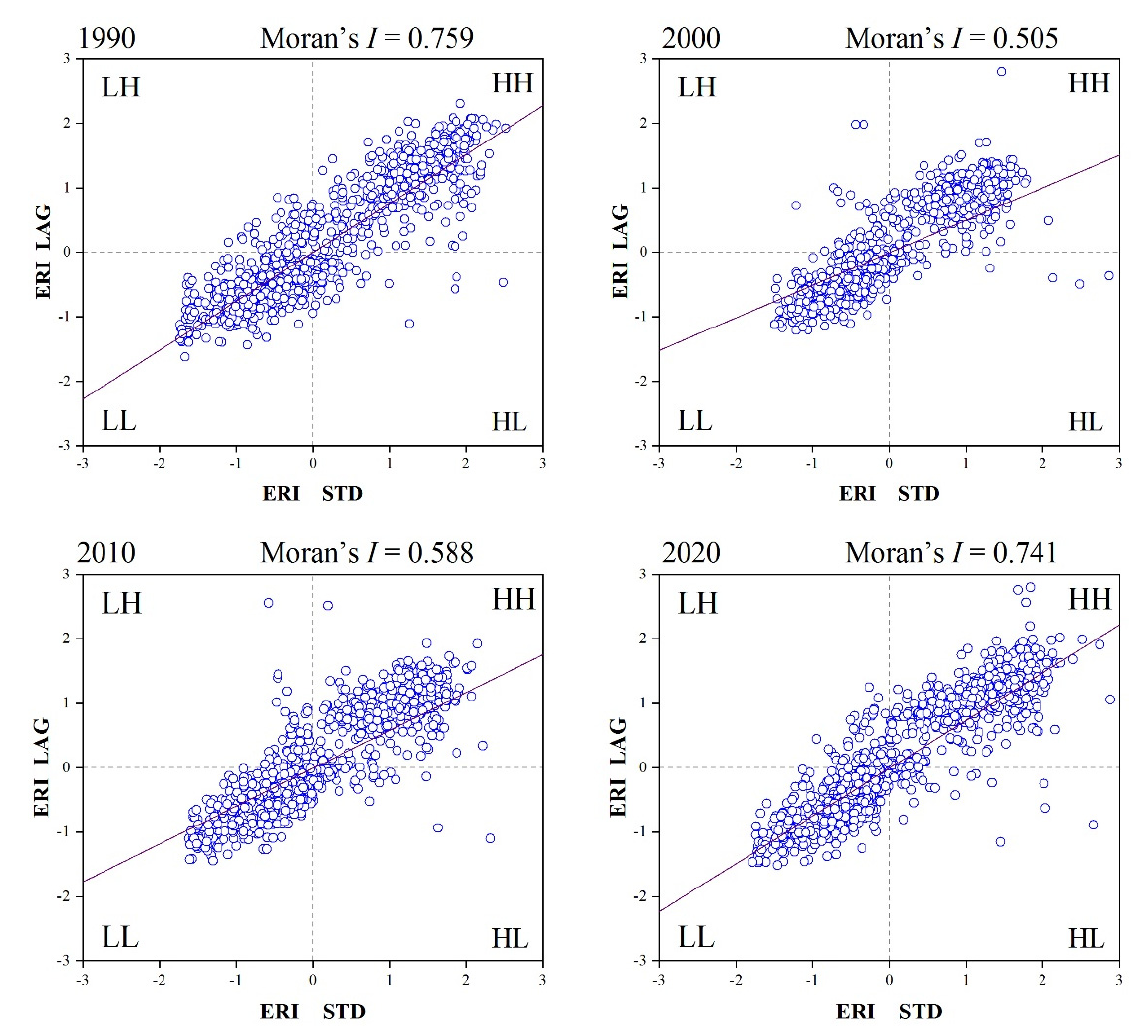
Figure 5. Moran’s I scatter plot of ecological risk in Gandaki river basin from 1990 to 2020. Subsequently, we applied the LISA to visualize the landscape scale agglomeration characteristics and spatial dynamics at the time scale of ecological risk from 1990 to 2020 (Figure 6). The general characteristics of the spatial clustering of ecological risks in the GRB were relatively similar over the 30 years and changes occurred mainly at local scales. In general, four spatial autocorrelation patterns are involved in the GRB: high–high, high–low, low–high and low–low. Among them, high–high agglomeration and low–low agglomera- tion were the dominant patterns of spatial autocorrelation. However, the distribution of the two patterns was dramatically spatially heterogeneous. Specifically, the high–high risk clusters were mainly located in the northern part of the basin, in line with the medium high ecological risk area concentrated in the north of the Himalayas, including the Gyirong County in China and the Annapurna and Manaslu conservation areas in Nepal. The low–